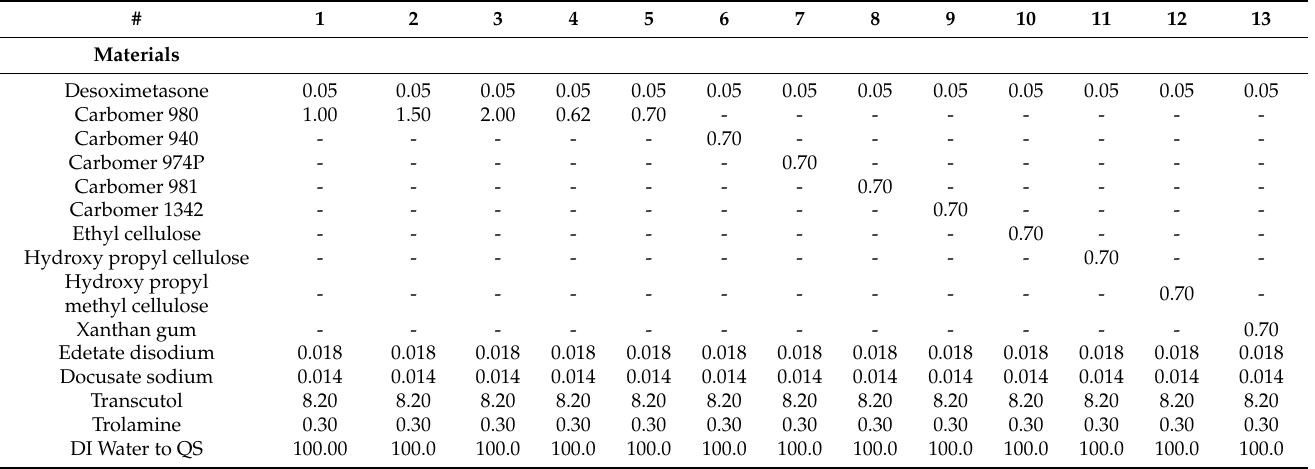
Table 1. Composition of topical desoximetasone niosomal gels as DNTG (Desoximetasone Niosomal Topical Gel) (% w / w ). # 1 2 Materials Desoximetasone